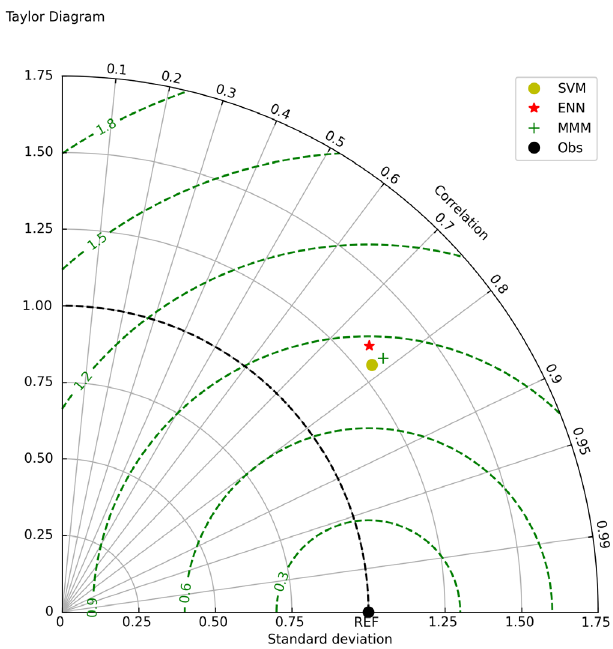
Figure 12. Taylor Diagram.